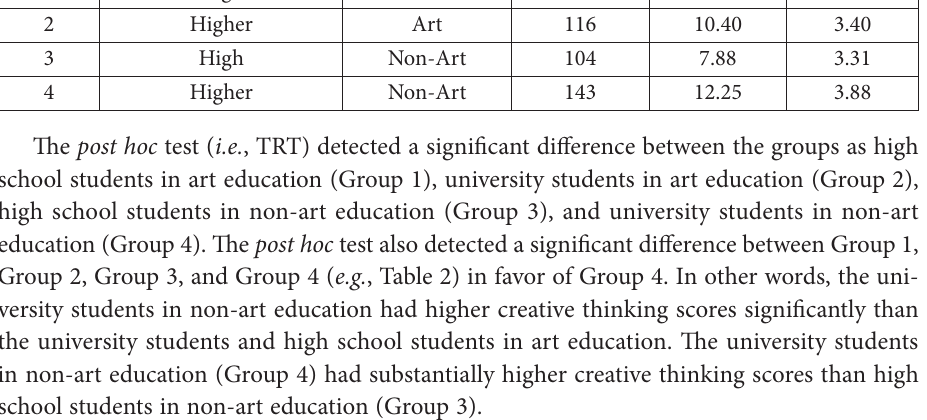
Table 4. Descriptive statistics of the groups upon the Torrance Tests of Creative Thinking cores (source: created by author)